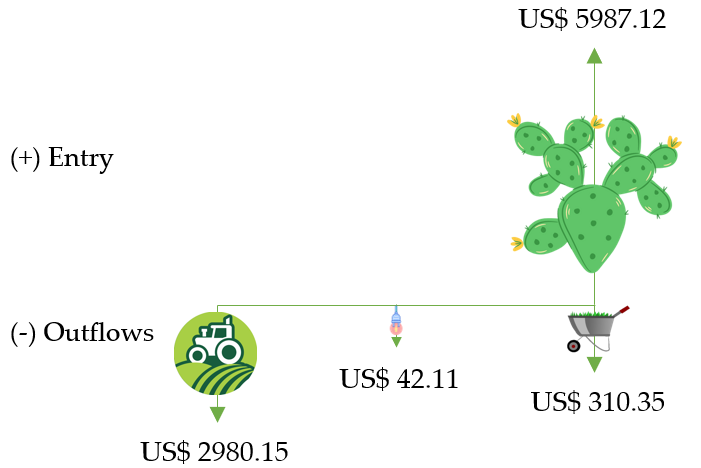
Figure 1. Cash flow of the cactus ( Opuntia ficus-indica ) cultivation system in the semi-arid region of Northeast Brazil, in a period of 3 years.